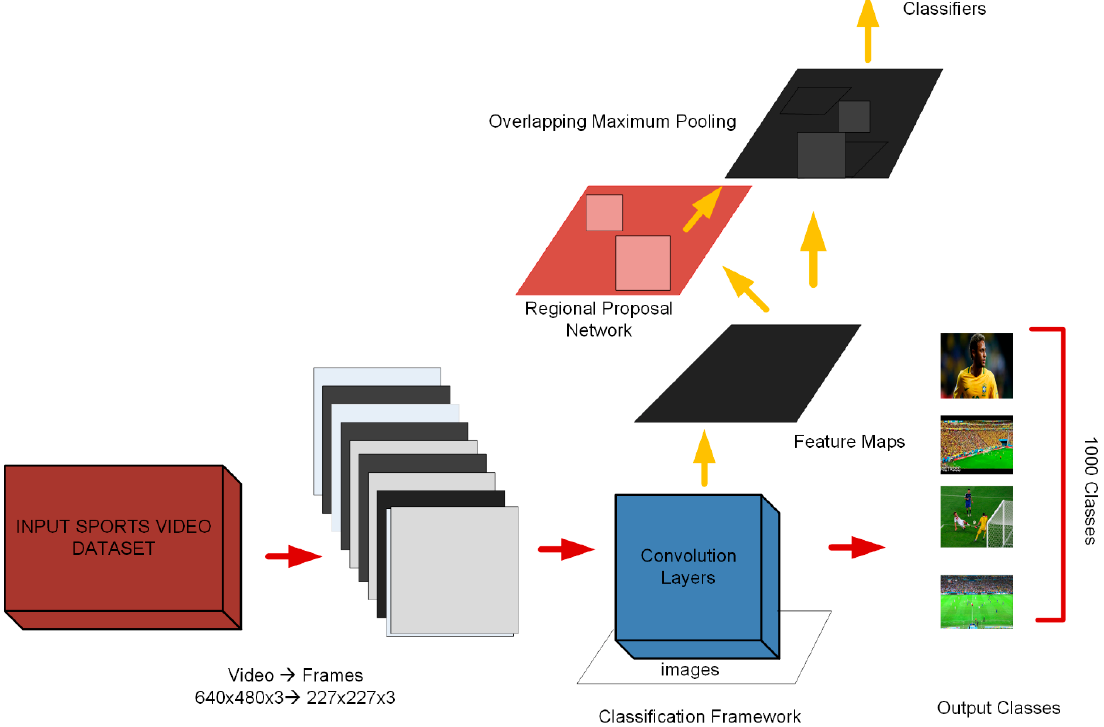
Figure 1. Proposed framework for shot classification.